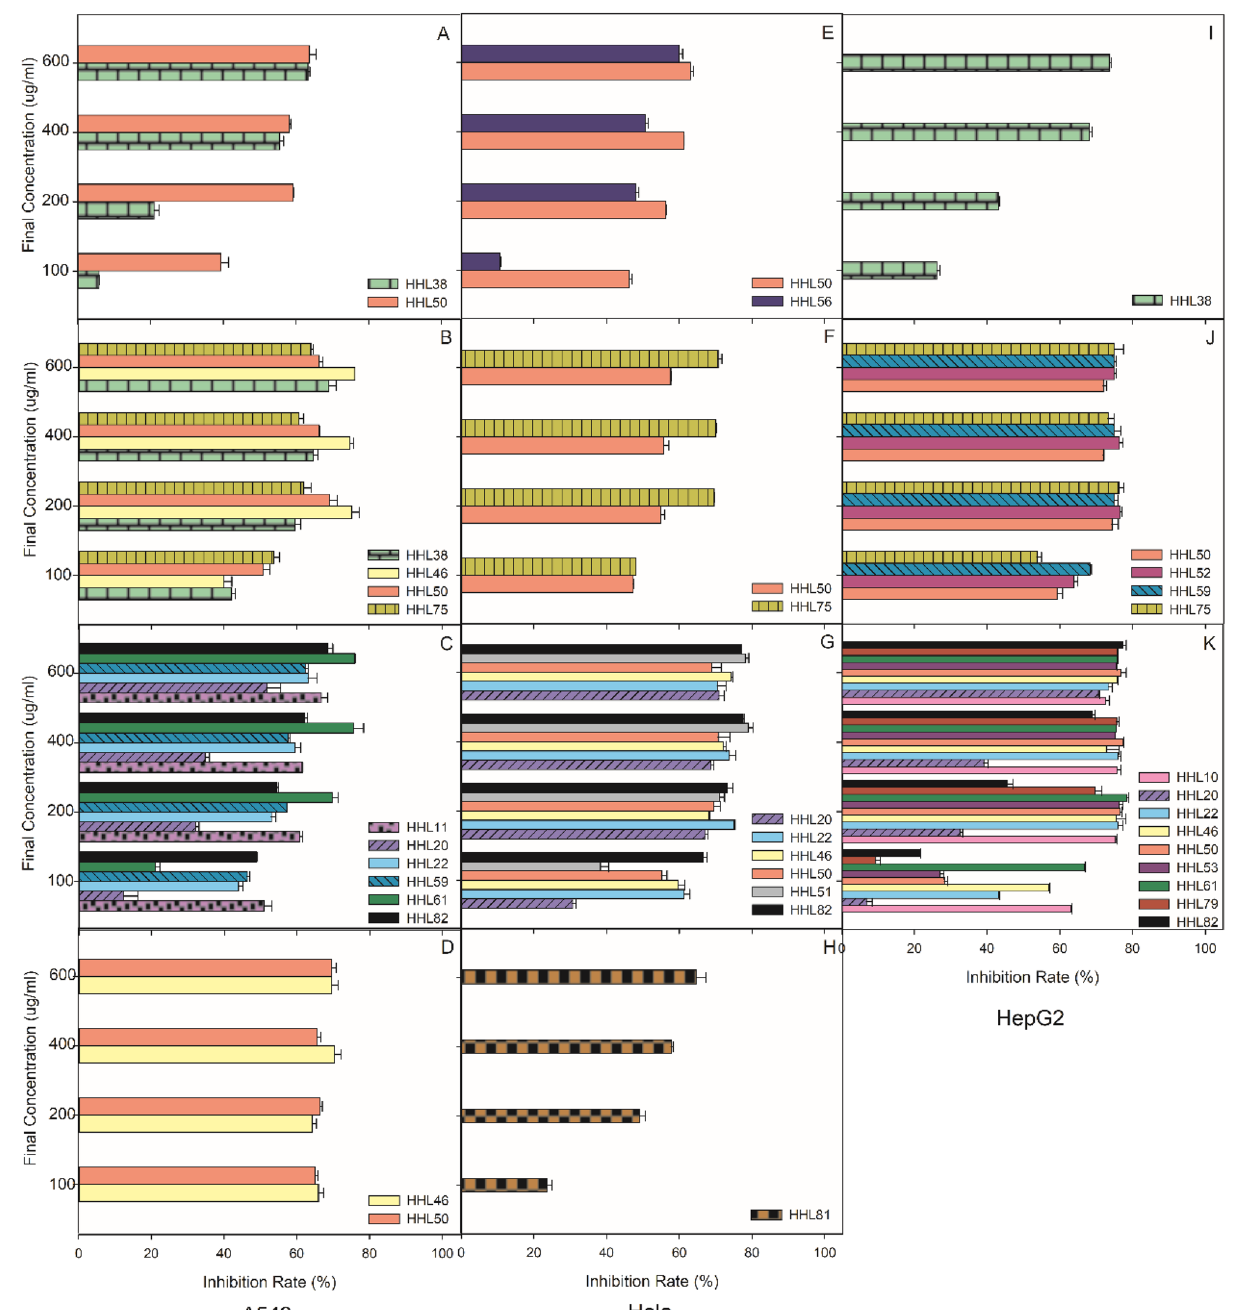
Figure 1. Antitumour activity of endophytic fungi from R. stylosa . ( A – D ) Shows that the fermentation products of endophytic fungi of R. stylosa have an inhibition rate for A549 tumour cells in different media, where ( A ) is obtained under dextrose agar (PDA) culture conditions, ( B ) is obtained under Czapek’s agar (CZA) culture conditions, ( C ) is obtained under rice medium (RM) culture conditions and ( D ) is obtained under grain medium (GM) culture conditions. ( E – H ) Shows that the fermentation products of endophytic fungi of R. stylosa have an inhibition rate for HeLa tumour cells in different media, where ( E ) is obtained under dextrose agar (PDA) culture conditions, ( F ) is obtained under Czapek’s agar (CZA) culture conditions, ( G ) is obtained under rice medium (RM) culture conditions and ( H ) is obtained under grain medium (GM) culture conditions. ( I – K ) shows that the fermentation products of endophytic fungi of R. stylosa have an inhibition rate for HepG2 tumour cells in different media, where ( I ) is results under dextrose agar (PDA) culture conditions, ( J ) is results under Czapek’s agar (CZA) culture conditions, and ( K ) is results under rice medium (RM) culture